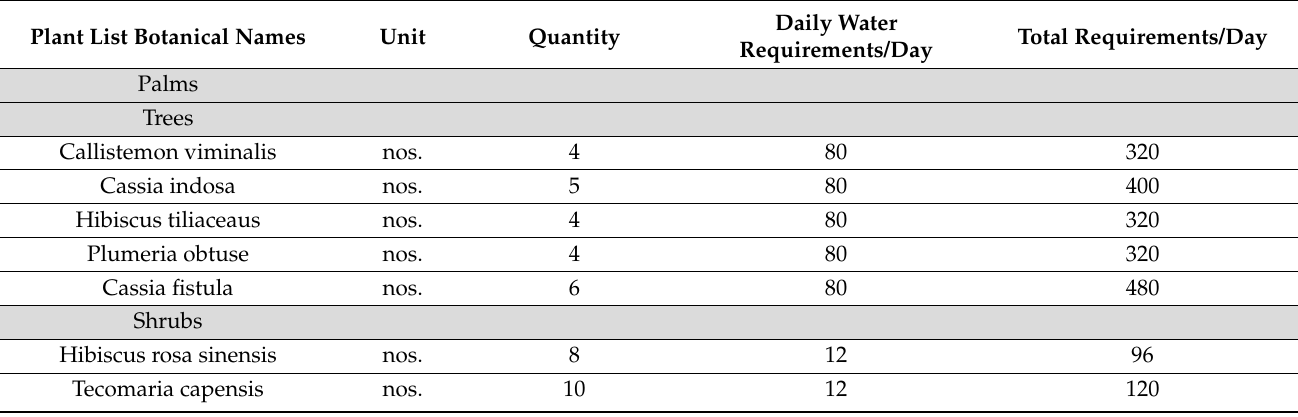
Table A6. Water consumption for each softscape item: Applying xeriscaping for PARKING 4